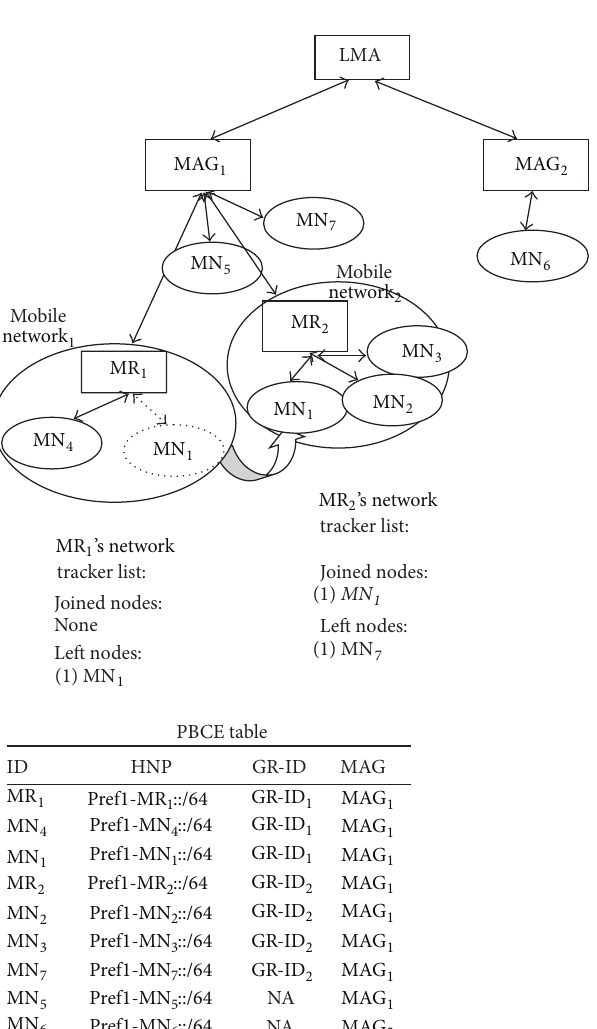
Figure 3: Intra-MAG movement: mobile node moves between mobile networks which are under the same